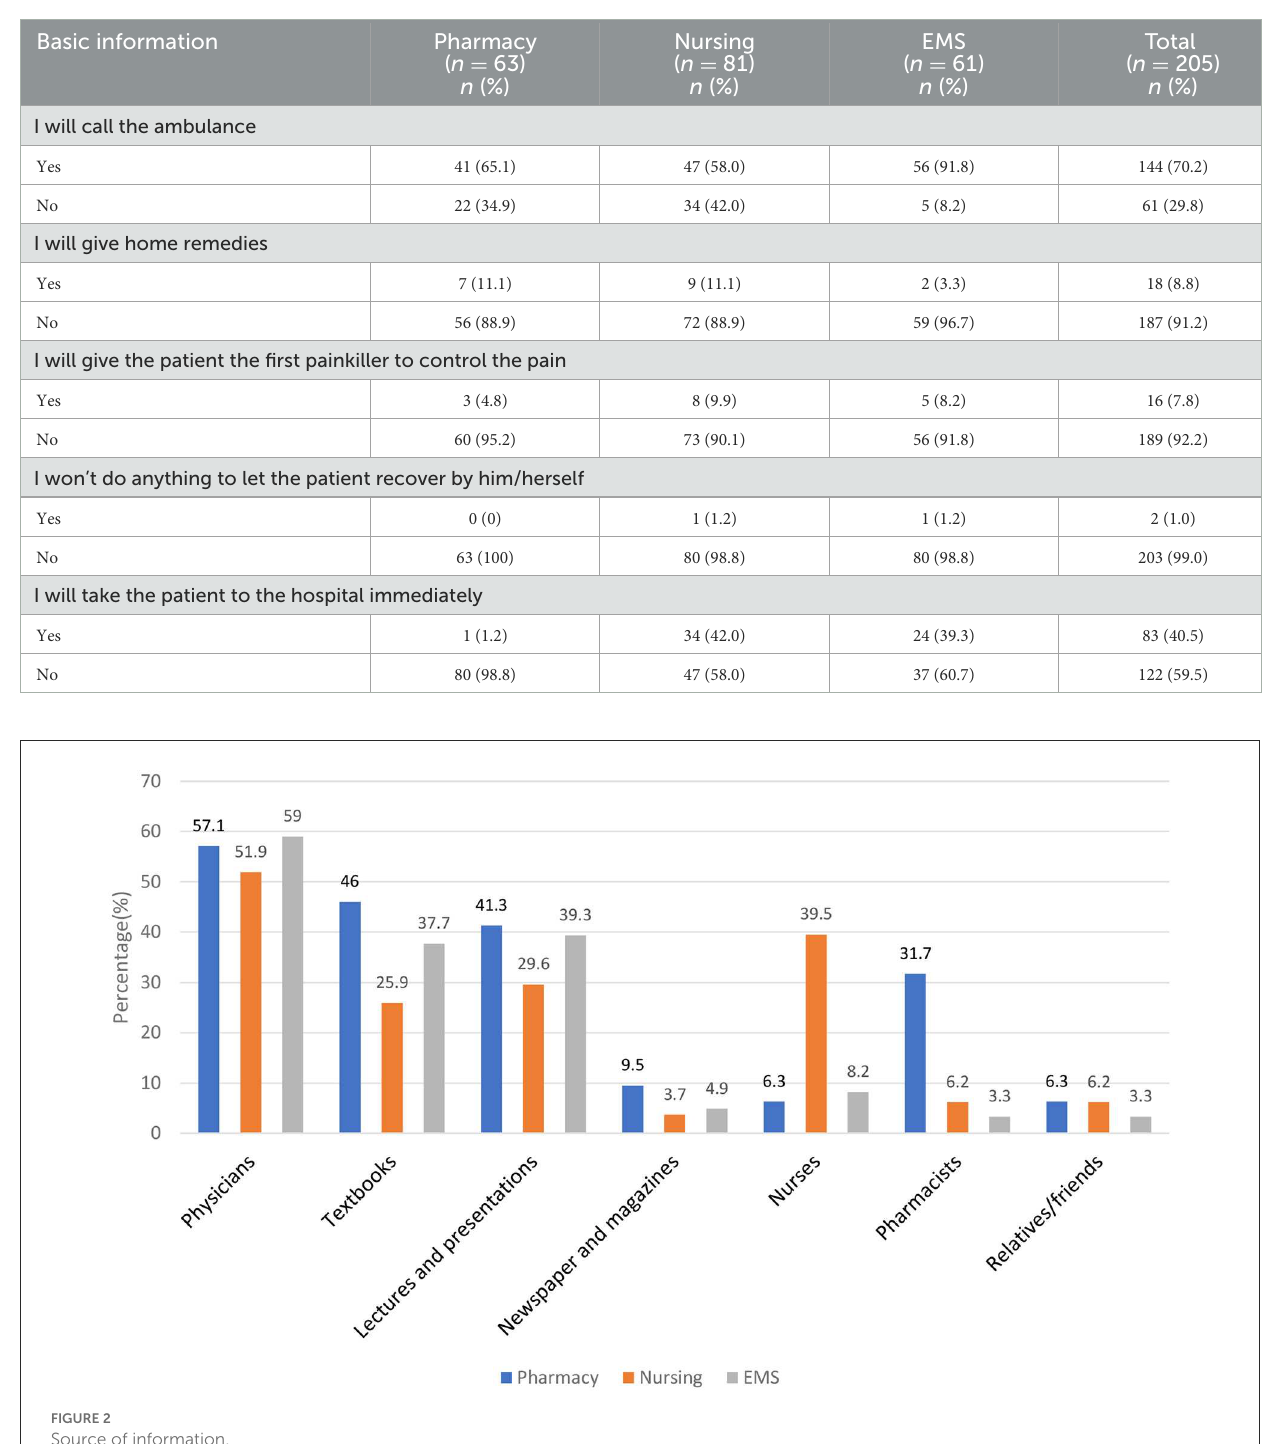
TABLE 4 Participants responses toward management of stroke.